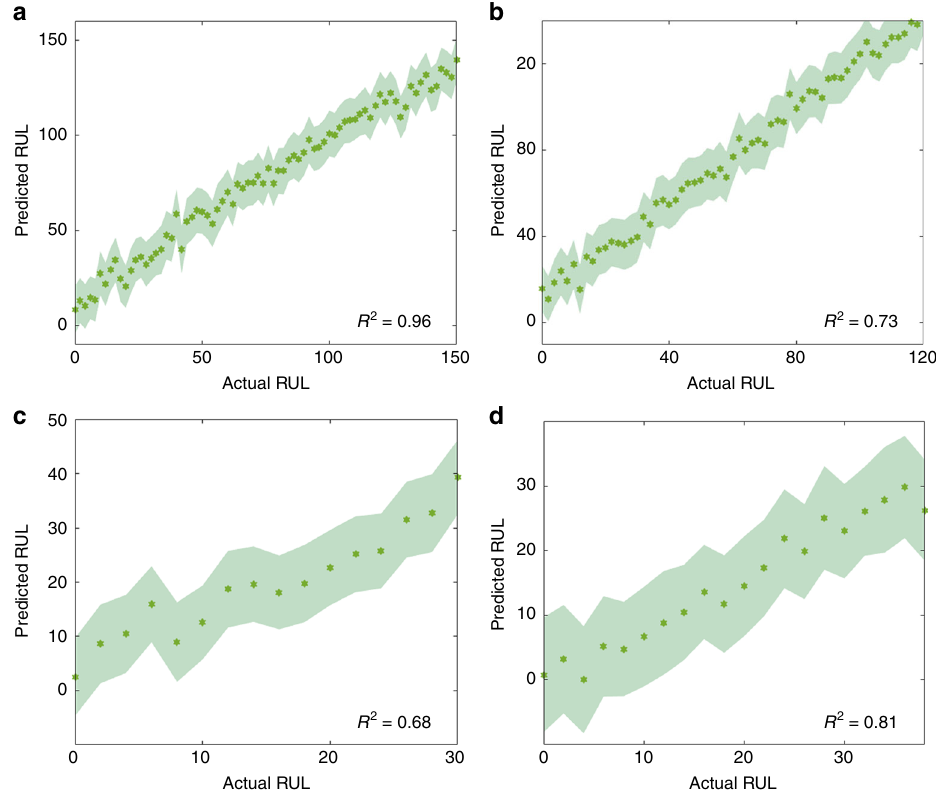
Fig. 2 Predicting remaining useful life. The predicted RUL of 25C05 – 25C08 testing cells a – d cycled at 25 °C (shown as green curves). The end of life (EoL) of these four testing cells is 150, 120, 30 and 38, respectively, which is de fi ned as the cycle number when the capacity drops below its initial 80%. The testing EIS spectra are collected at the state V (15 min resting after fully charging). The shaded region indicates ±1 standard deviation. R 2 is shown on the right bottom in each